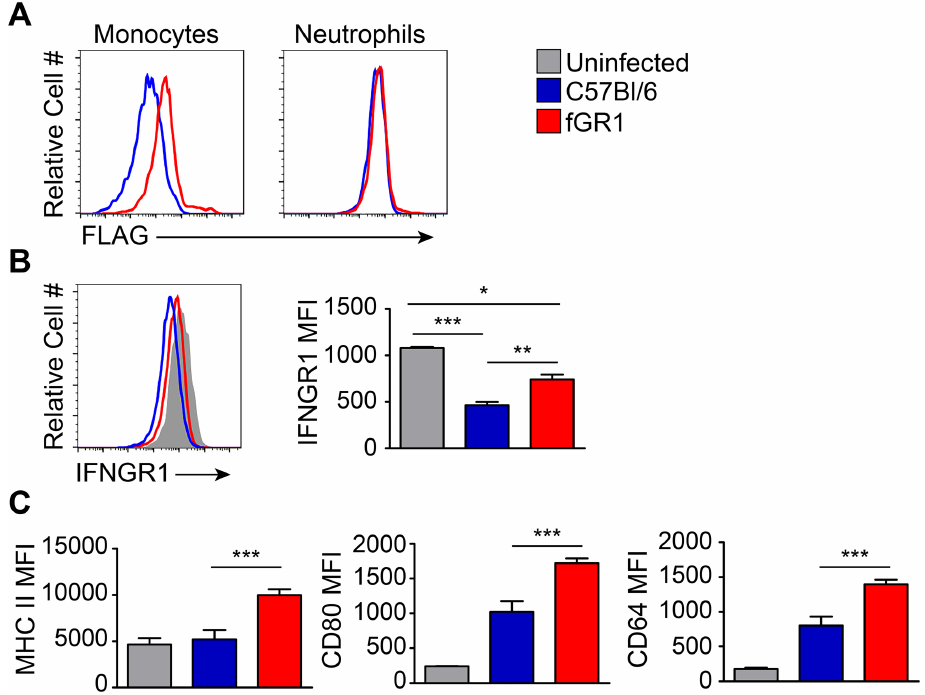
Fig 5. Heightened pro-inflammatory phenotype of fGR1 inflammatory monocytes during L . monocytogenes infection. Splenocytes from WT (blue) and fGR1 (red) mice 96 hpi L . monocytogenes infectionwere analyzedfor A) FLAG expressionon inflammatory monocytes (CD11b hi , Ly6C hi , Ly6G lo , gated S3A Fig) and neutrophils(CD11b hi , Ly6C hi , Ly6G hi ). B) IFNGR1 and C) “M1”-like pro-inflammatory activation markers MHC II, CD80, and CD64 on splenicinflammatory monocytes. (Representative data of one independent experiment, n = 5–10 mice per group. Experiment repeatedat least three times. * Two-Tailed t-